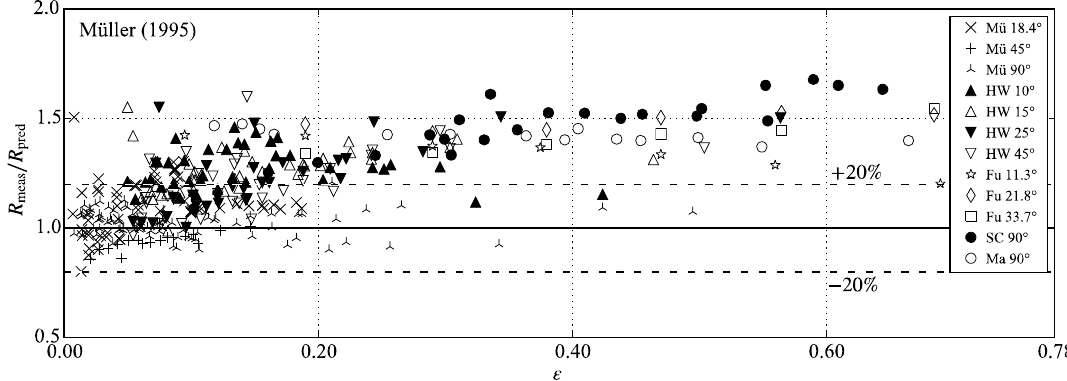
Figure 5. Measured over predicted (Equation (1) by Müller [7]) runup height R meas / R pred versus relative wave crest amplitude ε for experiments from data sources from Müller (Mü) [7], Hall and Watts (HW) [14], Fuchs (Fu) [20], Street and Camfield (SC) [21], and Maxworthy (Ma) [19].